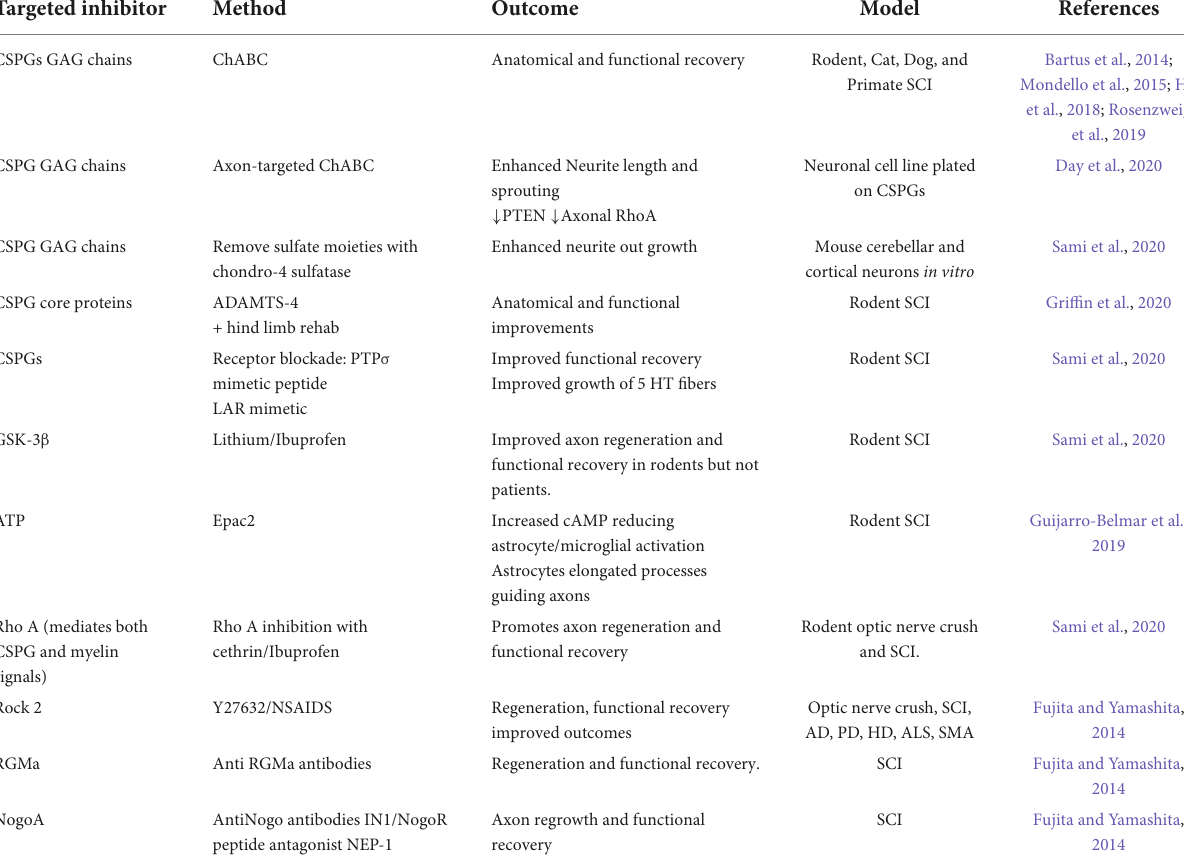
TABLE 1A Counteracting the effects of scar-derived